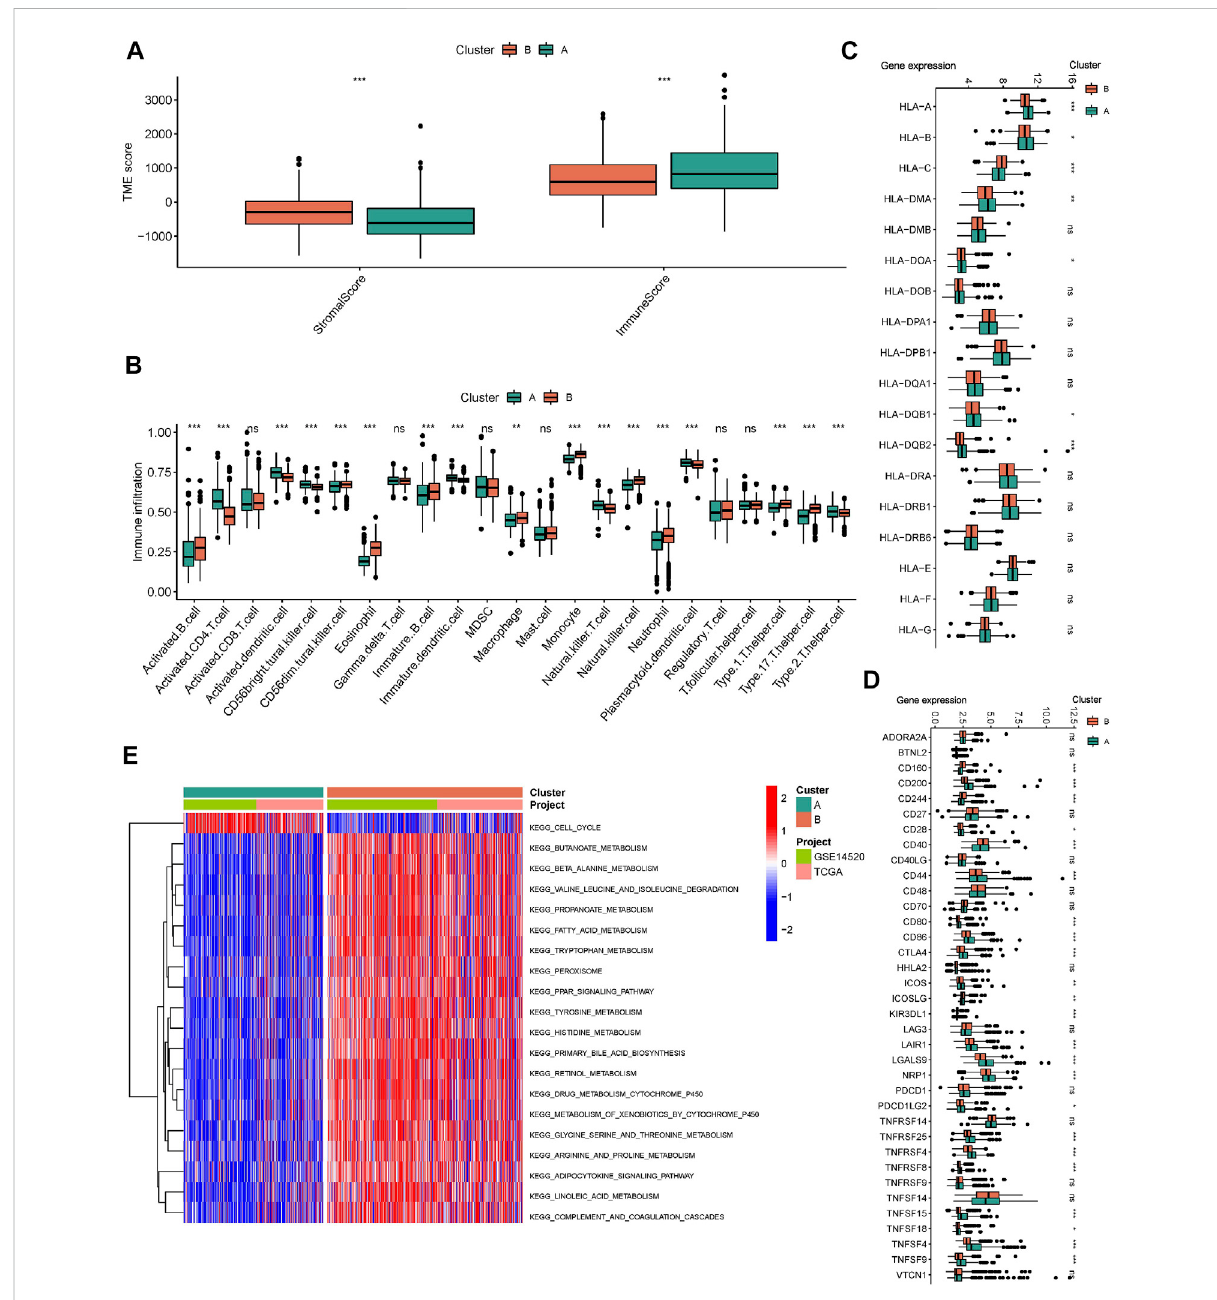
FIGURE 3 Immune microenvironment and biological pathways in molecular subtypes. (A) The Box plot of TME score in different molecular subtypes. (B) The Box plot of immune cells score based on ssGSEA in different molecular subtypes. The Box plot of mRNA expression of HLA (C) and ICIs (D) in different molecular subtypes. (E) GSVA analysis in different molecular subtypes using KEGG genesets. * p < 0.05, ** p < 0.01, *** p <